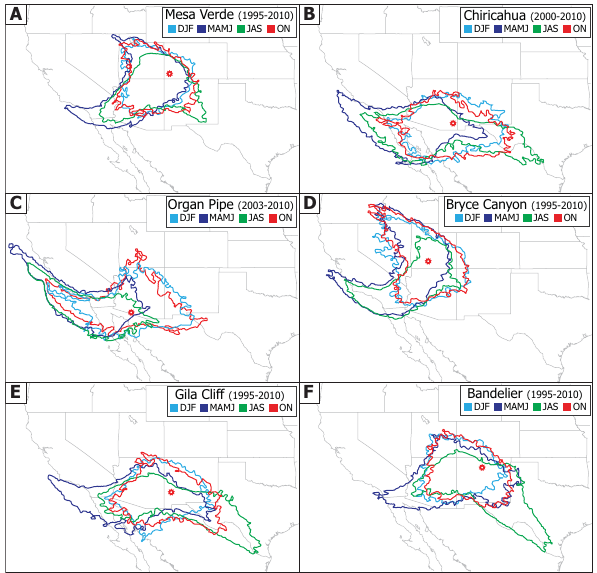
Fig. 2. Seasonal HYSPLIT data showing the approximate source regions for air parcels ending 10m AGL at each of the six study sites that are represented by red open markers. The colored borders represent a minimum trajectory frequency of 1% using three-day back-trajectory data, where frequency is defined as the sum of the number of trajectories that passed through each point on the map divided by the number of trajectories